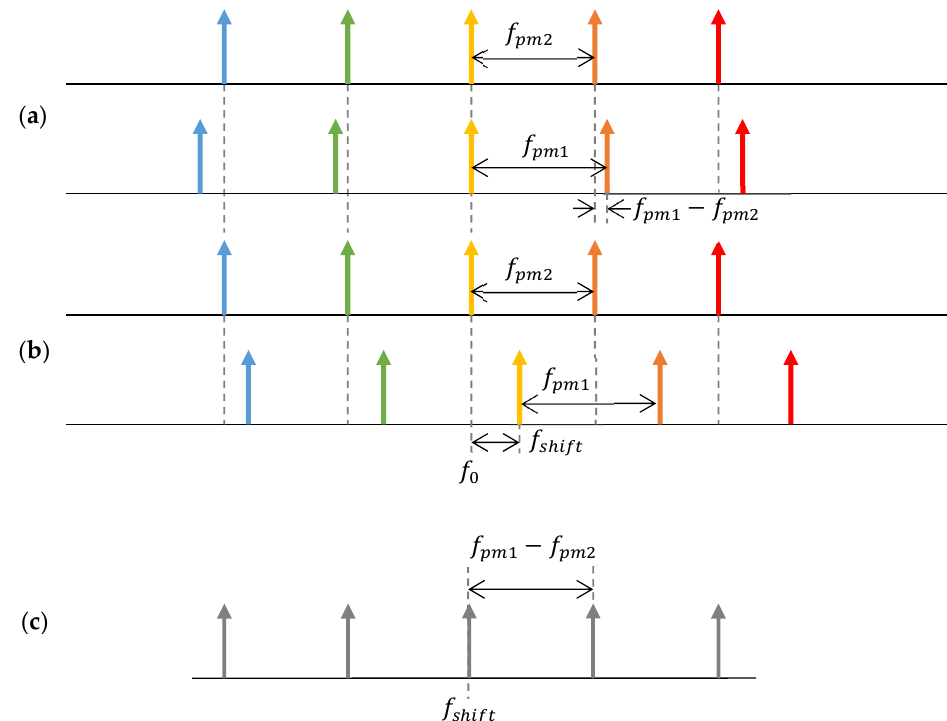
Figure 2. Electro-optic dual optical frequency comb spectra: ( a ) two optical frequency combs of slightly different frequencies applied to the phase modulator; ( b ) two optical frequency combs with additional frequency shifts; and ( c ) photo-detected comb as the beat response of the dual comb of ( b ).